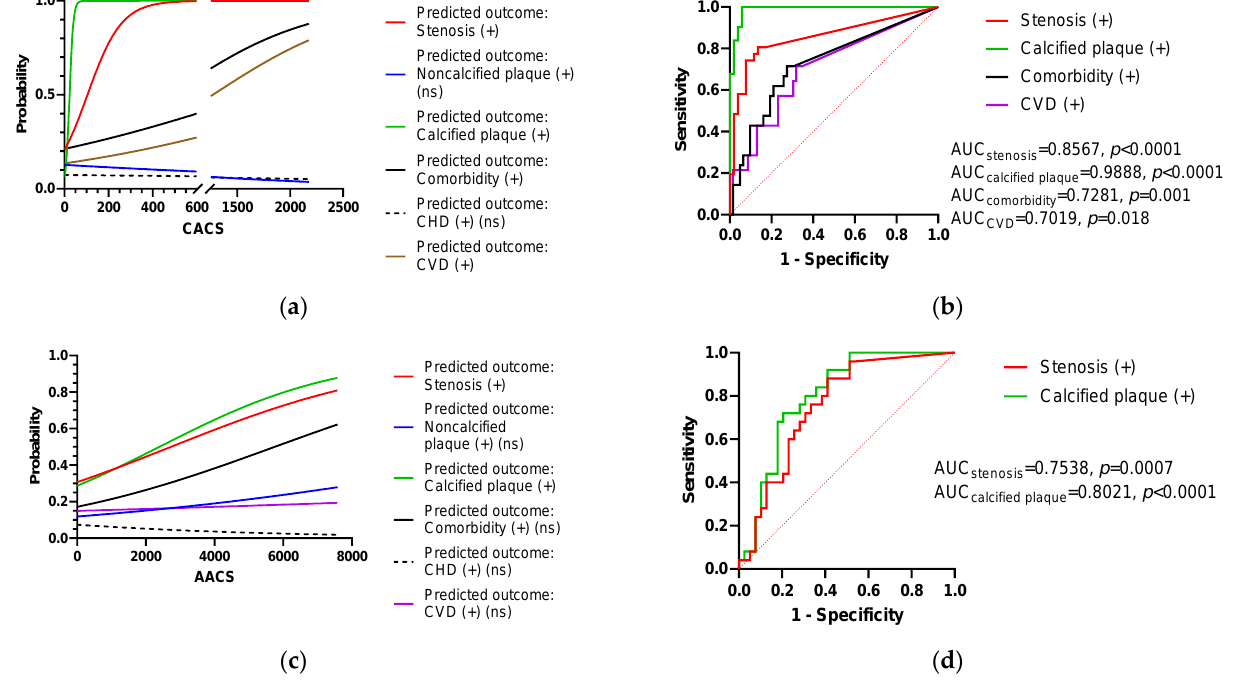
Figure 7. ( a – d ) : Value of CACS and AACS in the diagnosis of important outcomes and their relative sensitivities and specificities. (Red dotted line in ( b – d ): the AUC threshold is 0.5). Regarding the inconsistency between CACS and AACS in their association with the coronary stenosis confirmed by CCTA, AACS might only moderately reflect the status of coronary calcification, and it likely only partially reflects the calcification progress of the whole vascular bed. Several other factors might also contribute to the surge of AACS, such as systemic metabolism dysfunction, which might be specific to calcium deposition at the abdominal aorta. Indeed, in our study, we found that AACS, but not CACS, was significantly higher in patients with psoriasis with diabetes comorbidity (Table 6) in a similar manner to the way in which CACS, but not AACS, was specifically increased in psoriatic arthritis and pustular psoriasis (Figure 3f and Table 6). Furthermore, AACS was the highest in patients with psoriasis with other comorbidities but without CVDs (CHD, stroke, or arrhythmia) (Table 6). Similarly, AACS was not increased along with the increase in coronary plaque until the end, although it still rose relatively compared to its trajectory in those with no coronary plaque at all (Figure 4a). Therefore, there may no longer be a close association between AACS and the involvement noted by CCTA in the polar region of these two variables. The polar region of these two variables might be the place where some unclear factors are specifically working for the vascular calcification of each different location, and we would rather choose the more precise and direct parameters for patients in this polar region. Particularly in patients with various known damages to the CCTA, CACS accurately reflects the degree of involvement and is easier to follow during the follow-up examination than AACS. Otherwise, in patients with extremely high AACS results (more than 6000–8000), AACS at that time might no longer be an indicator for suspected widespread coronary damage. As a result, we prefer conducting a CACS or CCTA test at that time. In conclusion, although AACS represents an alternative means to predict coronary stenosis, it might not be suitable to distinguish between stenosis degrees and the spread of calcified coronary plaques.